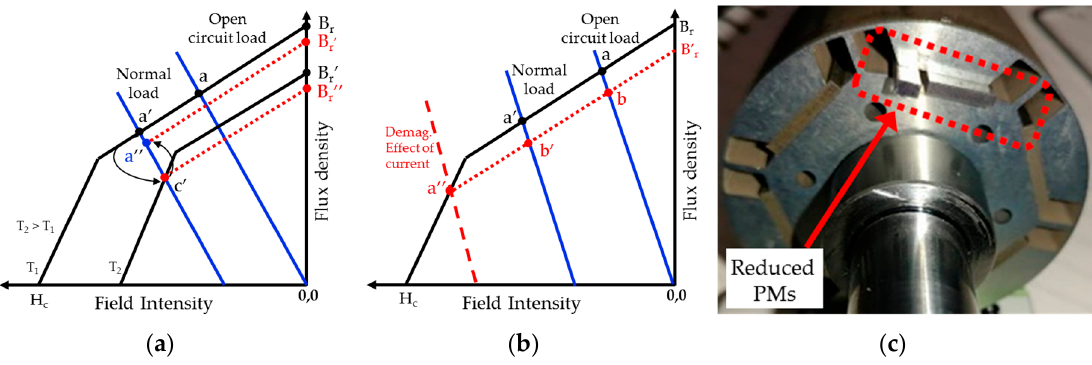
Figure 3. Operating point and demagnetization curve of PM due to: ( a ) External demagnetizing MMF; ( b ) Operation at high temperature (NdFeb or SmCo magnets); ( c ) IPMSM rotor with replaceable reduced size PMs.